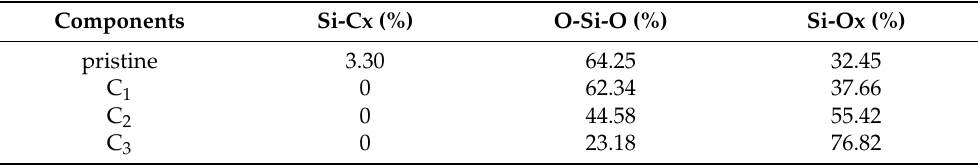
Table 4. Composition of Si 2p peaks on the surface of each samples.